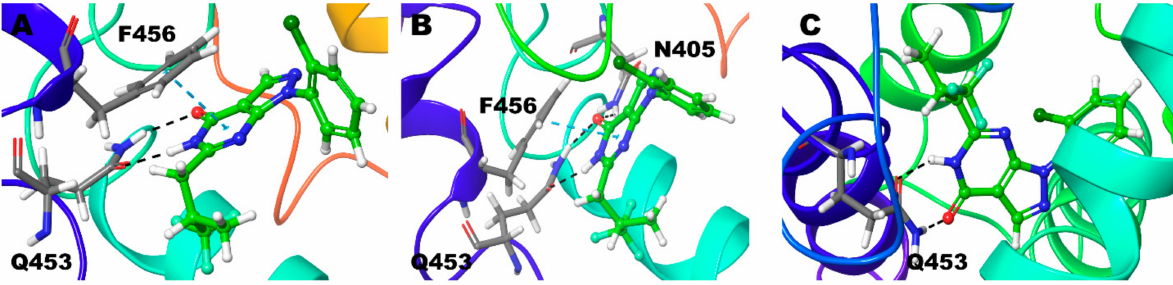
Figure 4. Non-bonded interactions of Compound 1 ( S ) in ( A ) PDE9 Zn/Mg ( B ) PDE9 Mg/Mg ( C ) PDE9